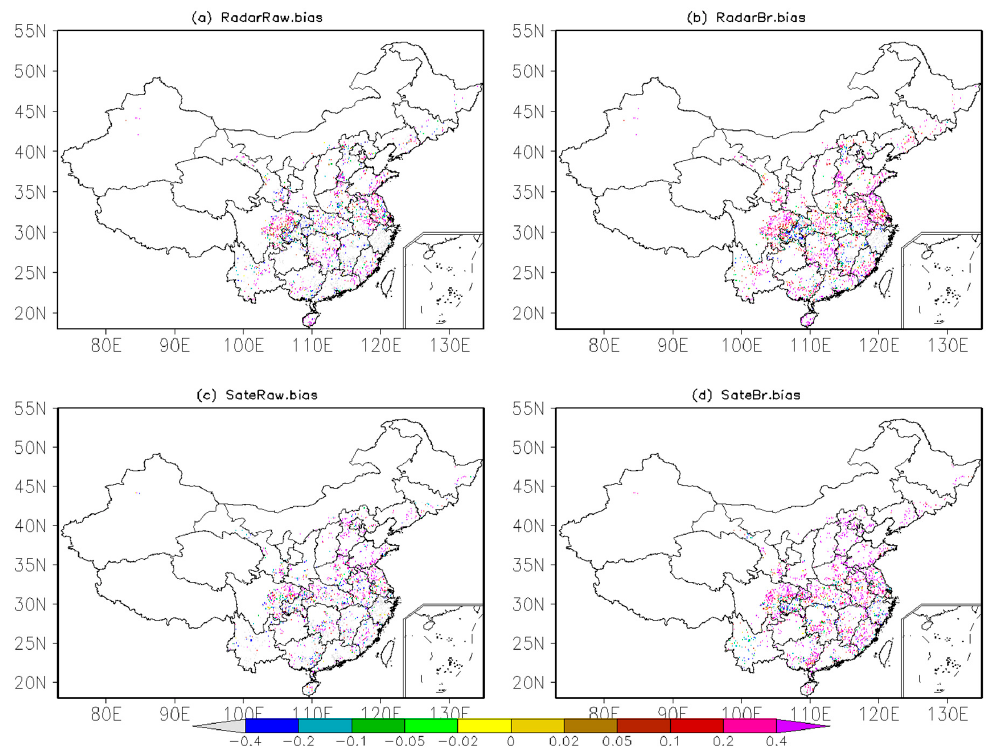
Figure 11. Spatial distribution of bias with and without local bias correction for radar ( a , b ) and satellite ( c , d ) at 0.01 degree lat./lon. grid.